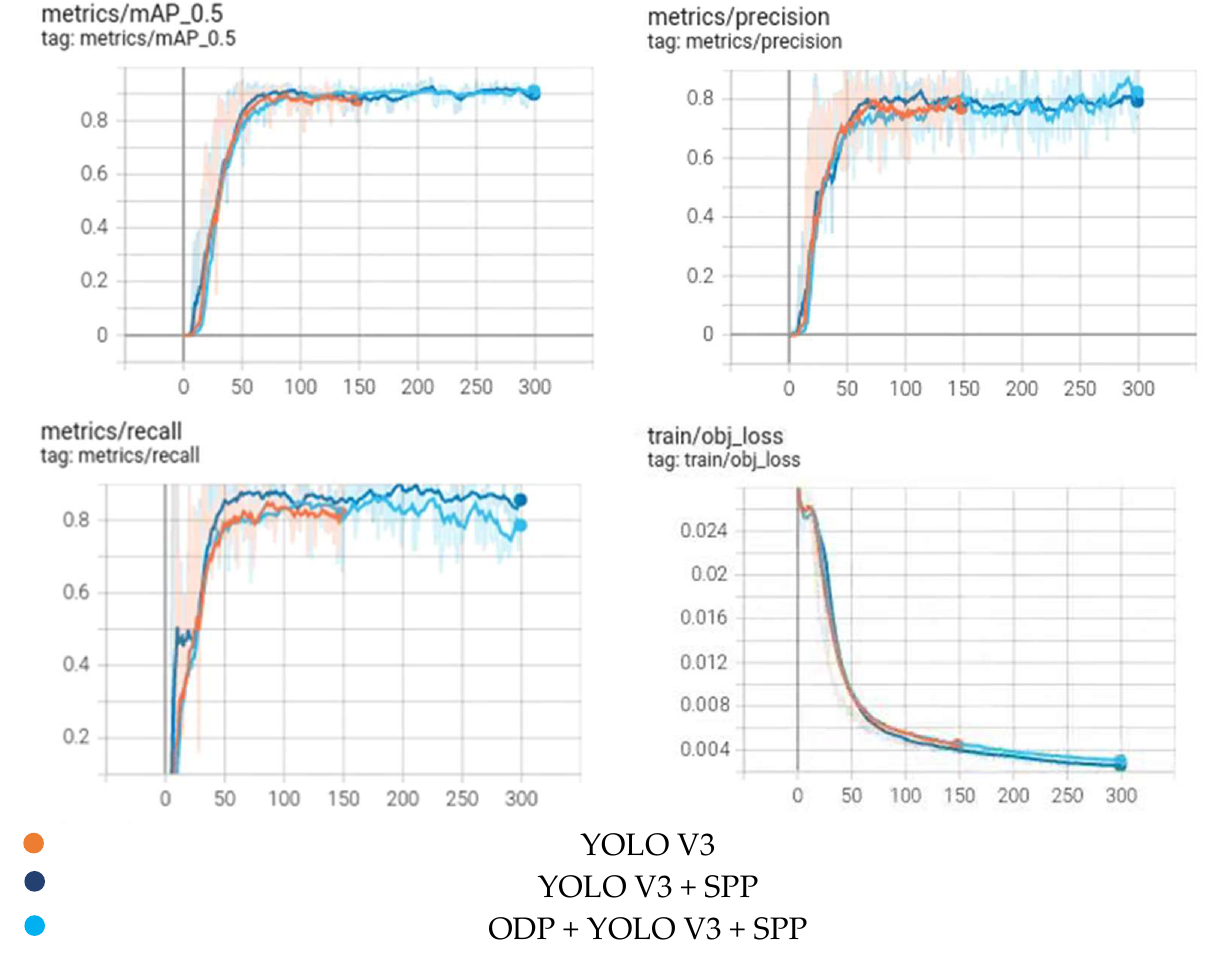
Figure 14. The performance of YOLO groups comparison analysis.